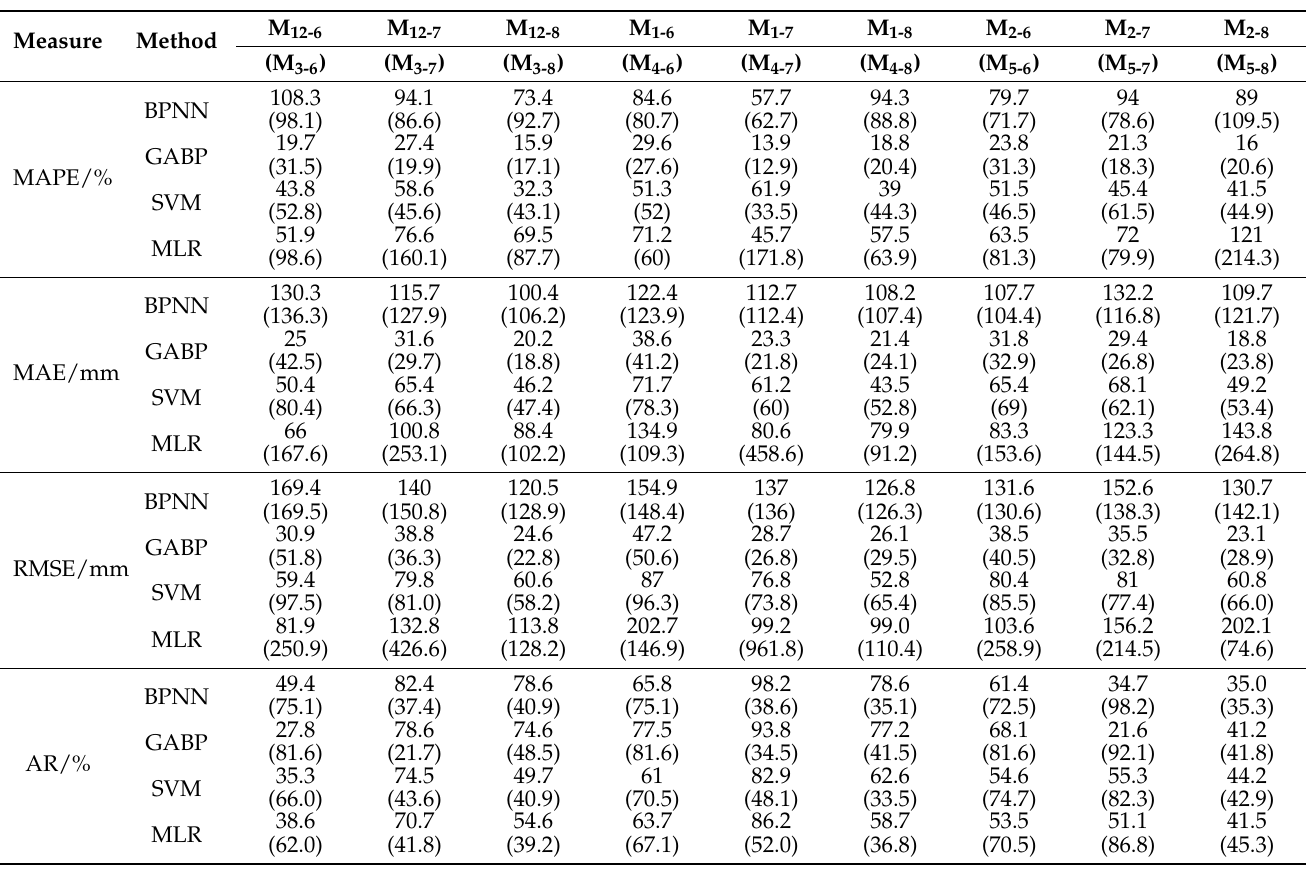
Table 1. Basin-averaged evaluation measures of various models, where each model is denoted with a subscript that contains two numbers; the former and latter numbers are respectively for the month of factors selected and the month of forecasted precipitation; e.g., M 12-6 means the model using the December factors to predict the June precipitation (also shown are the values in brackets in corre- spondence with the model in brackets).